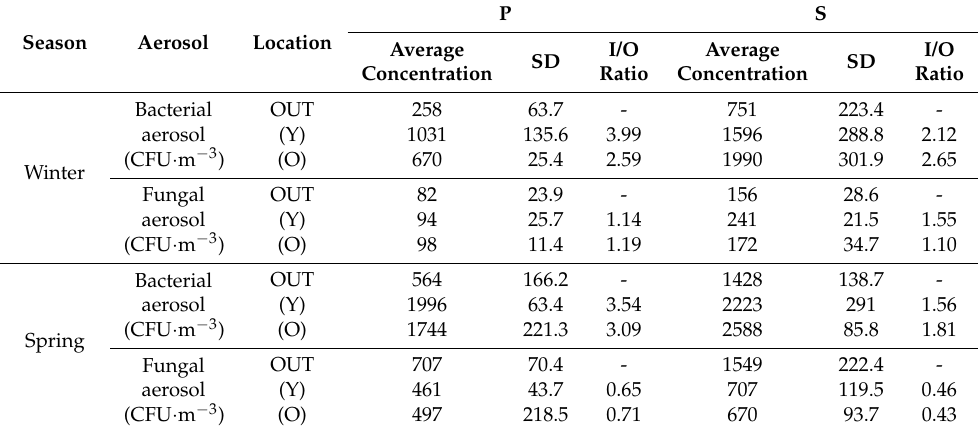
Table 2. Average concentrations of total bacterial and fungal colony-forming units per cubic metre of air in two nursery schools (P, S) in winter and spring season; (OUT)—outdoor; (Y)—younger children classroom; (O)—older children